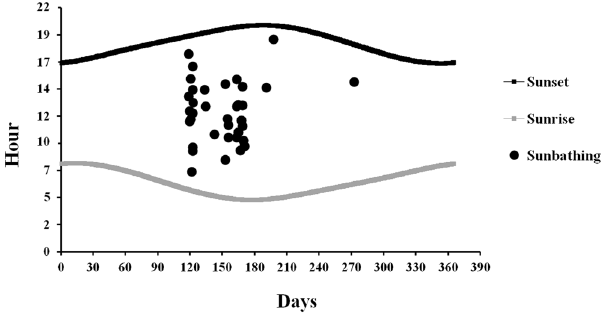
Figure 6. Graphical representation of the 36 episodes of sunbathing recorded in the monitored settlement in relation to the hour of sunset and sunrise during the year (21 December–20 December).